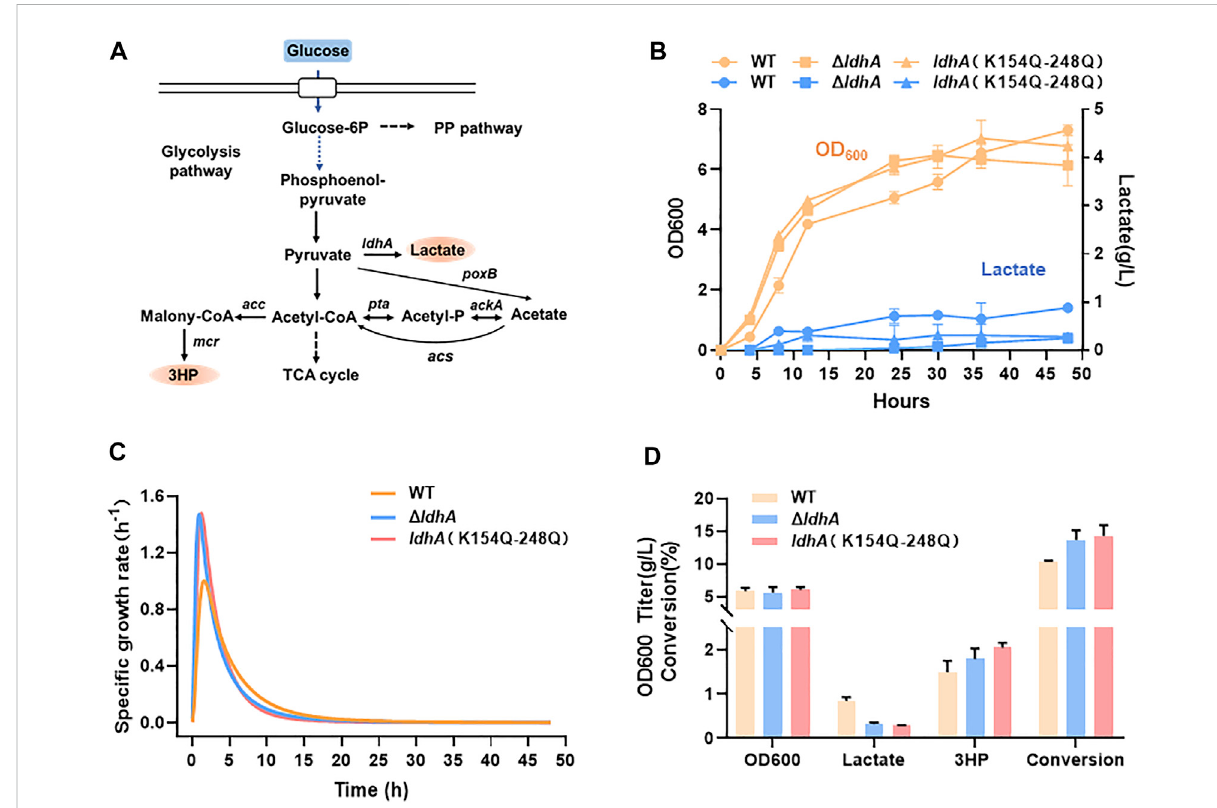
FIGURE 7 K154Q-K248Q mutantinhibitslactateaccumulation andimproves3HPproduction. (A) Thesyntheticpathwayoflactateand3HPfromglucose. (B) The cell growth and lactate accumulation of E. coli strains carrying wild-type LdhA and LdhA double mutant, and the ldhA deleted E. coli strain. The yellow line represents the cell growth, the blue line represents the lactate production. (C) The speci fi c growth rate of these strains. (D) The biomass and metabolic pro fi les of these strains in 3HP